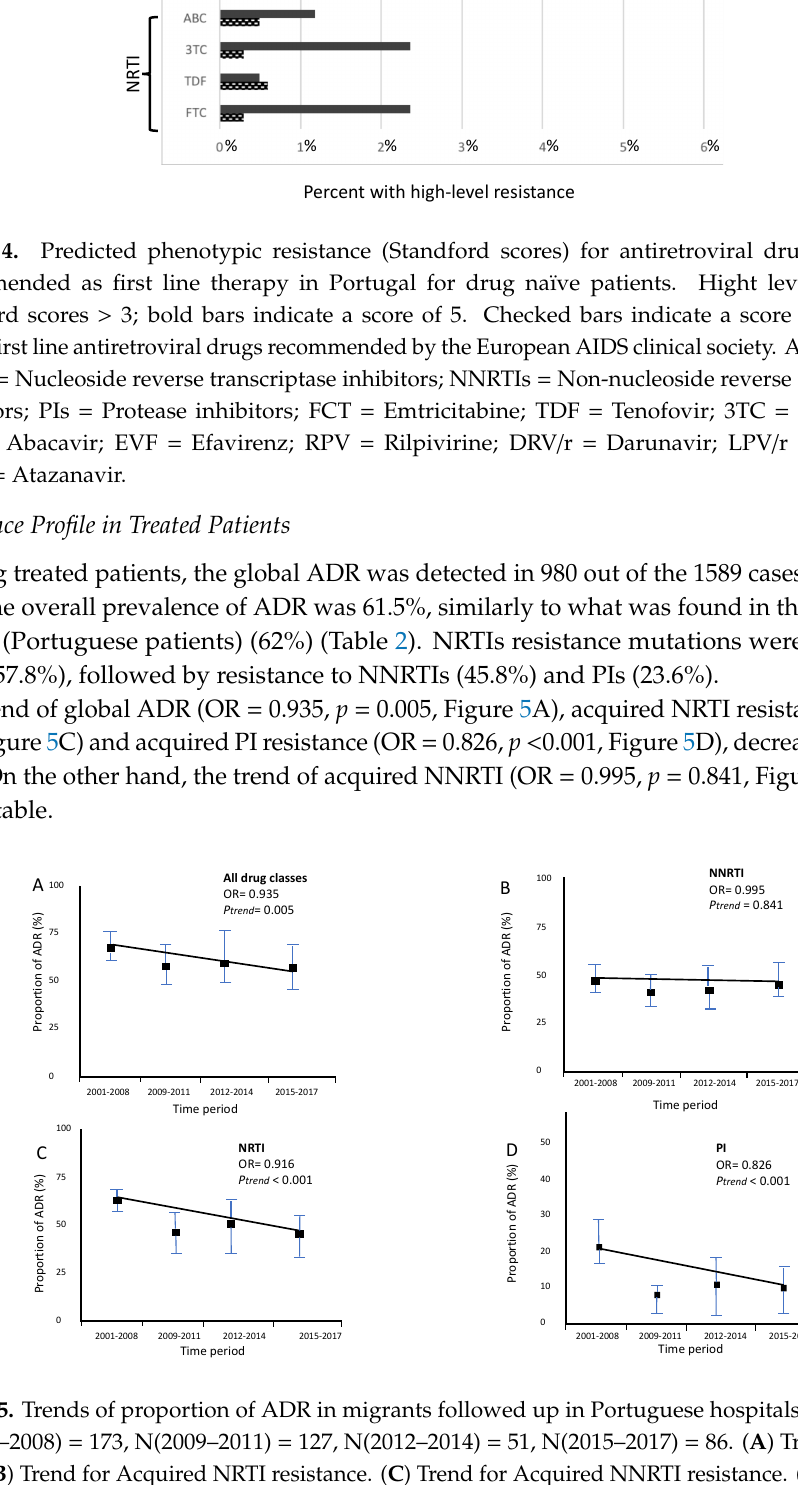
2 of 20 Figure 3: Proportion of human immunodeficiency virus (HIV) mutations in ( A ) drug-naïve patients and ( B ) treated patients between 2001 and 2017. For NNRTIs, 93 of 1017 sequences (9.14%) had mutations interpreted as moderate and high-level resistance. From those, 6.2% had moderate and high resistance to Efavirenz (EFV) and 2.8% to